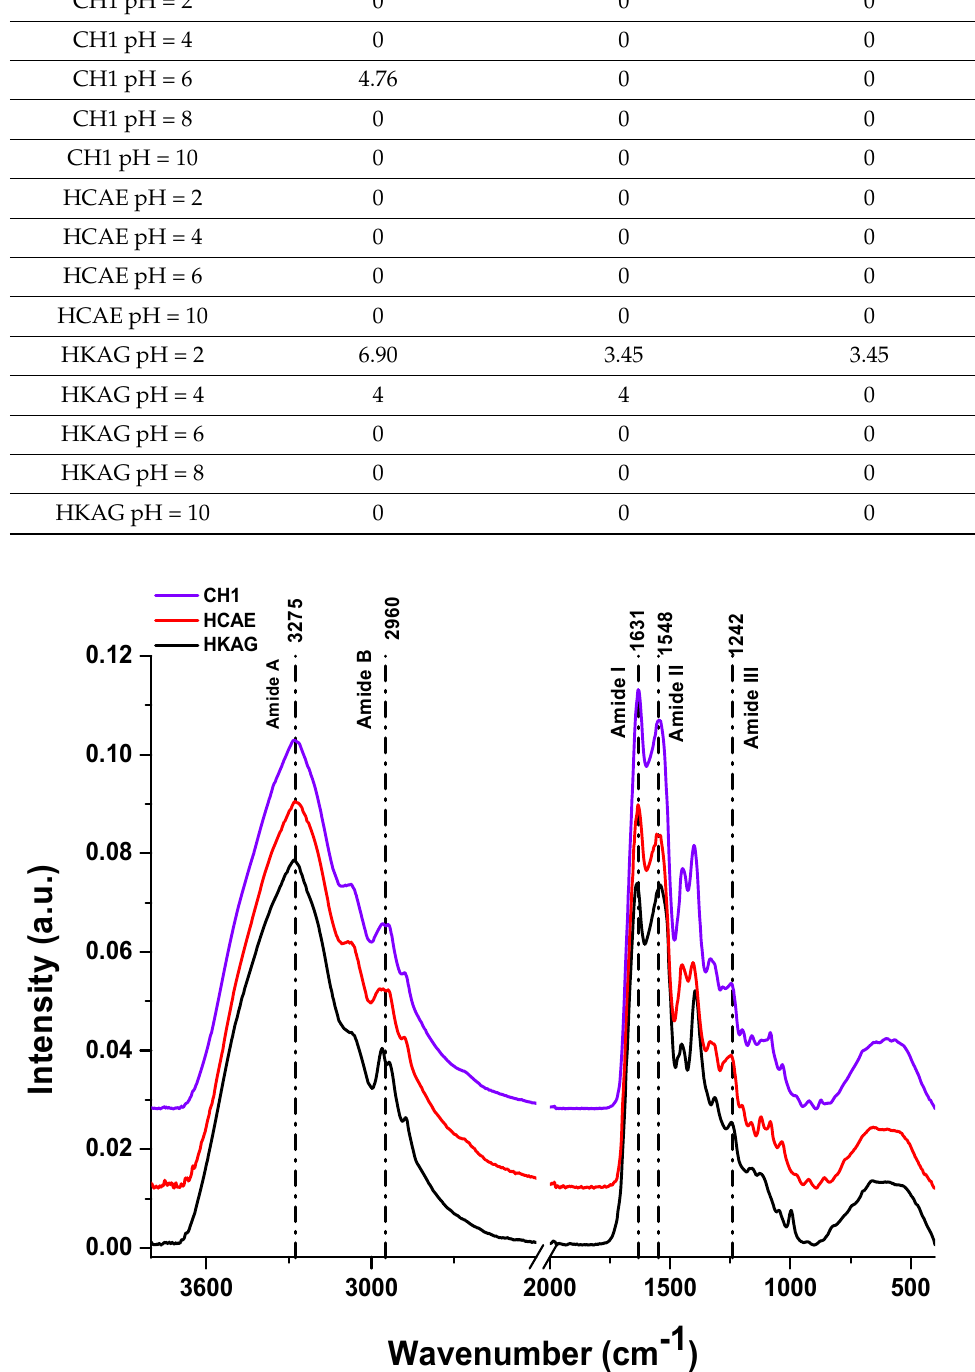
Table 2. The foam stability of protein hydrolysates, CH1, HCAE, and HKAG. Sample